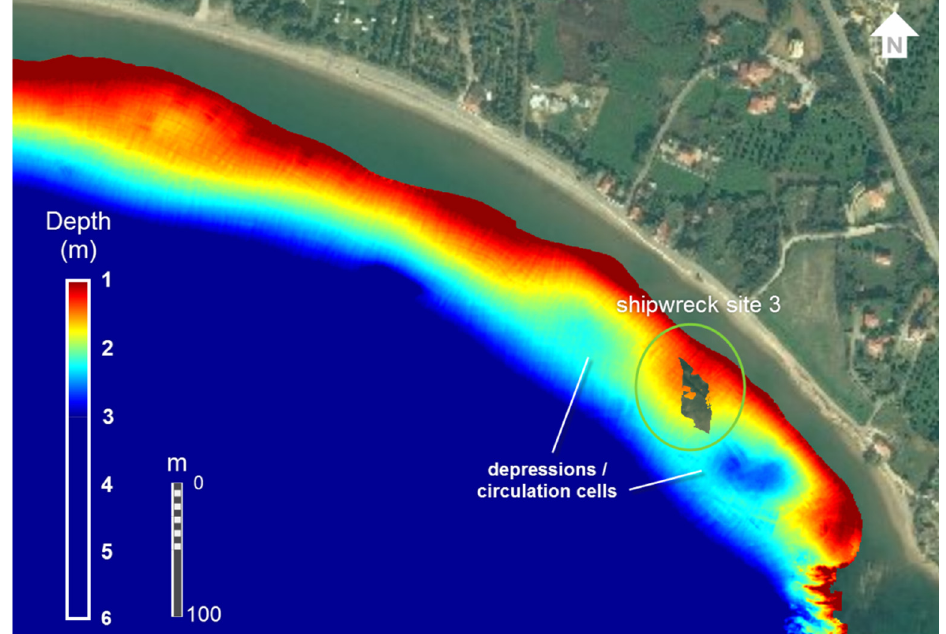
Figure 16. Nearshore and surf zone bathymetry across the northeast section of the Methoni Bay. Alongshore bathymetric nonuniformity is expressed with distinct, consecutive alongshore depositional and erosional bedforms, conceptually associated with cellular current circulation and the accumulation of sediments over shipwreck site 3. The georeferenced 3D model of the shipwreck ruins is shown uplifted over the bathymetric surface in the green circle. Background map data source: Esri, DigitalGlobe, GeoEye, Earthstar Geographics, CNES/Airbus DS, USDA, USGS, AeroGRID, IGN and the GIS User Community.